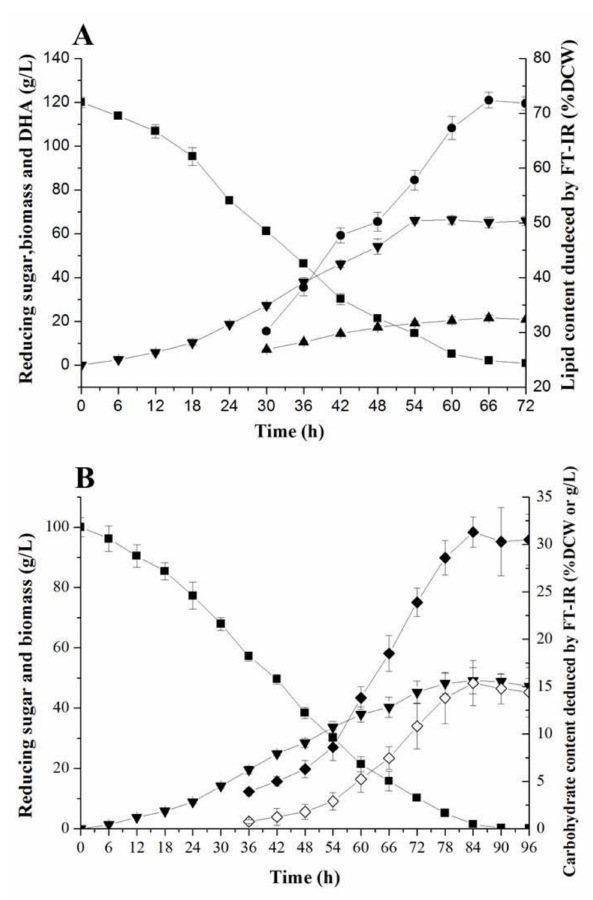
Figure 6. The fermentative performances of the Aurantiochytrium sp. strains No. 6 and No. 32 for lipid and carbohydrate productions under FT-IR monitoring. ( A ), lipid and DHA production by Aurantiochytrium sp. strains No. 6; ( B ), carbohydrate production by Aurantiochytrium sp. strains No. 32. Reducing sugar, filled squares; biomass, filled inverted triangles; lipid content, filled circles; lipid yield, filled triangles; carbohydrate content, filled diamonds; carbohydrate yield, open